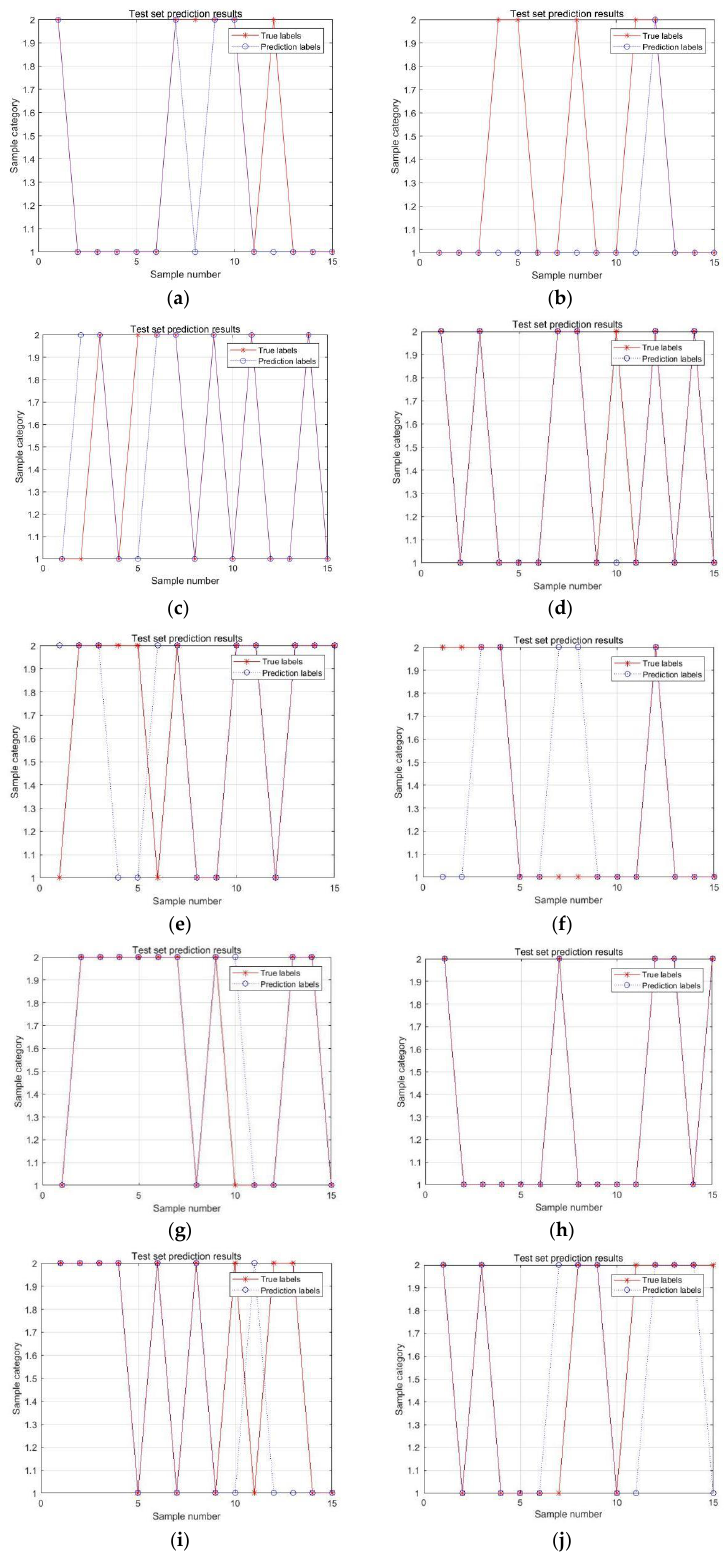
Figure 5. Classification effect of the test set data containing multidimensional efficiency index graphs. ( a ) The first test; ( b ) The second test; ( c ) The third test; ( d ) The fourth test; ( e ) The fifth test;